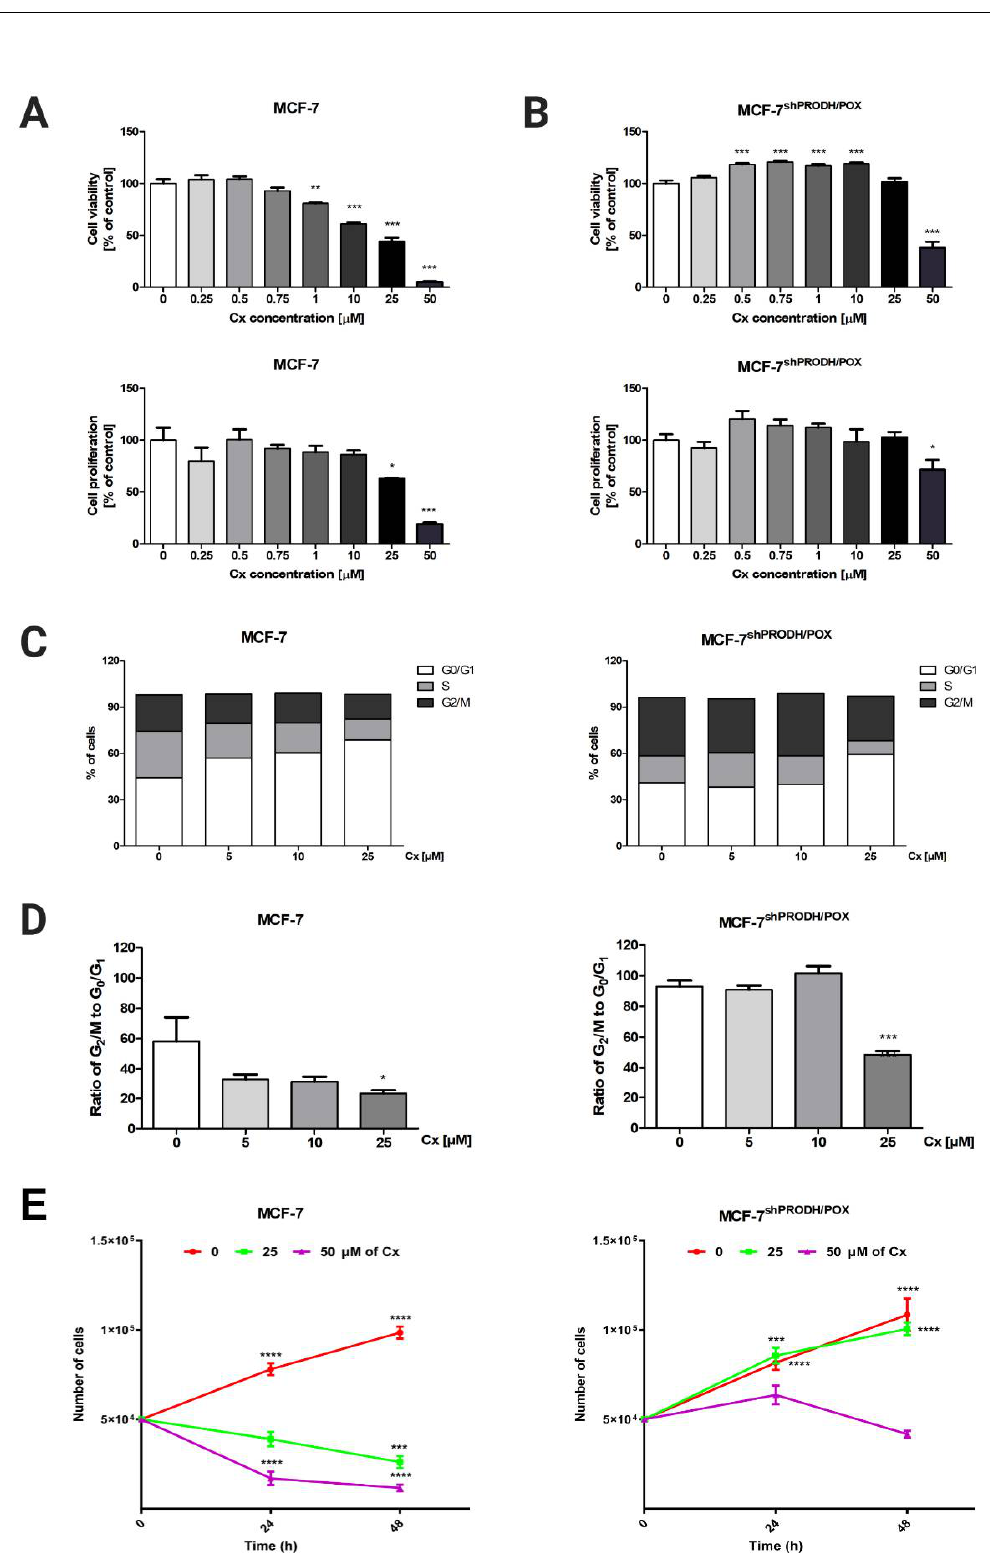
Figure 1. Celecoxib limits MCF-7 cell proliferation via arresting the cell cycle: ( A ) cell viability measured by Cell Titer Blue assay; ( B ) cell proliferation was studied by CyQuant Cell Proliferation Assay and the mean values were presented as a percent of control. Cells were treated with various concentrations of Cx (0, 0.25, 0.5, 1, 5, 10, 25, and 50 µ M) for 24 h. * p < 0.05, ** p < 0.01 and *** p < 0.001; ( C ) the percentage of cells in G 0 /G 1 , S and G 2 /M phases of the cell cycle of MCF-7 and MCF-7 shPRODH/POX cells; ( D ) the ratio of cell percentage in G 2 /M to G 0 /G 1 phase. * p < 0.05, ** p < 0.01 and *** p < 0.001; ( E ) The growth curve of cell treated with various concentrations of Cx (0, 25, and 50 µ M) for 24 and 48 h; * p < 0.05, ** p < 0.01, *** p < 0.001, and **** p < 0.0001.